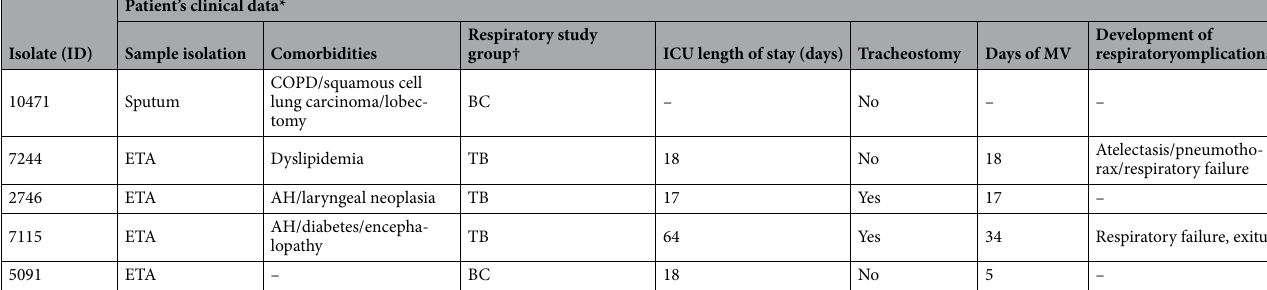
Table 1. Identification of isolates and associated clinical information. *ETA: endotracheal aspirate; COPD: chronic obstructive pulmonary disease; AH: arterial hypertension; MV: mechanical ventilation. †BC: bronchial colonization; TB: tracheobronchitis. Respiratory study groups according to the Clinical Pulmonary Infection Score (CPIS) as previously described 61